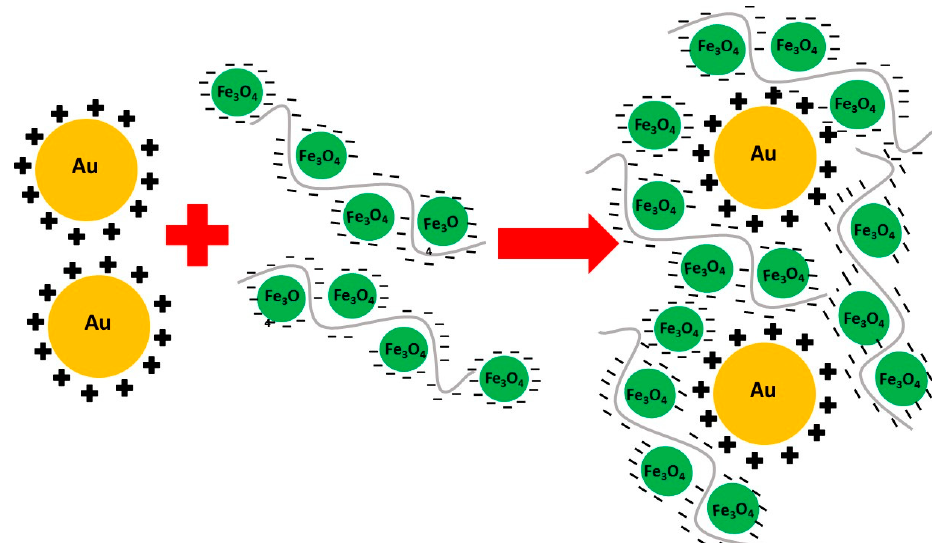
Figure 1. Scheme illustrating the formation of the magnetic-plasmonic nanocomposite. The minus signs around the Fe 3 O 4 nanoparticles indicate the negative charge of the PSS stabiliser, and the positive signs around the Au nanoparticles indicate the positive charge of the PAH stabiliser.